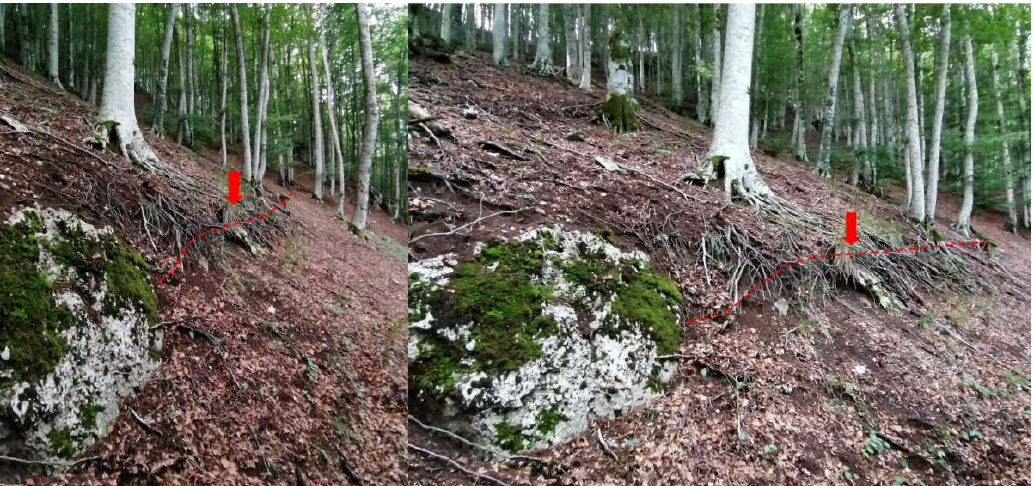
Figure 3. The coseismic 1980 fault scarp along M.te Carpineta, 40 years later (Photos by Giuliana